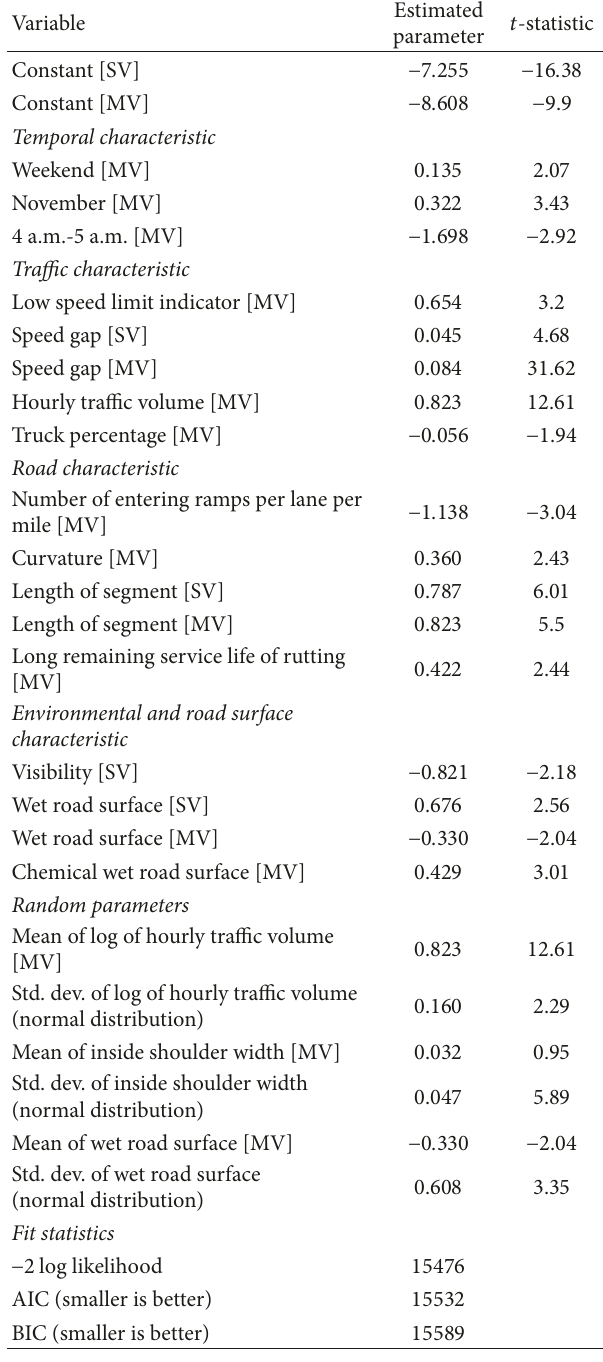
Table 2: The estimated results of mixed logit model with three crash